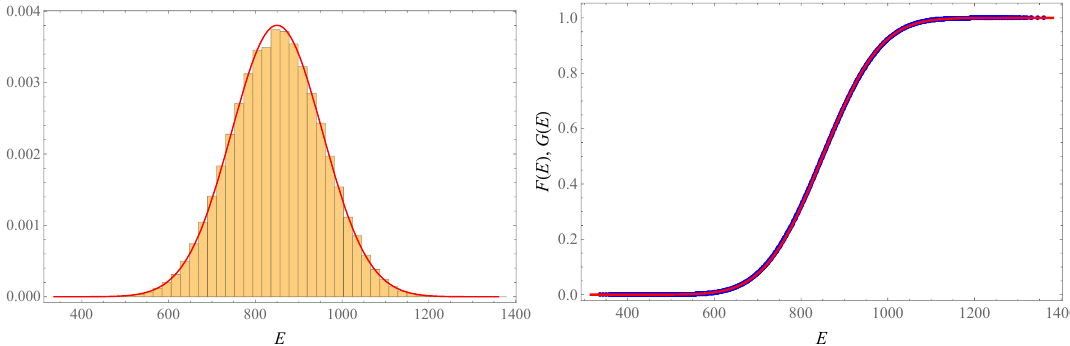
Figure 5 . Left: histogram (normalized to unit area) of the degeneracies of the levels of the chain (2.1) with m = 4 and N = 16 spins compared to the Gaussian distribution (red line) with parameters (cid:22) and (cid:27) respectively equal to the mean and the standard deviation of the model’s energy spectrum. Right: plot of the cumulative level density F ( E ) of the latter model (blue dots) compared to the cumulative Gaussian distribution (6.3) (solid red